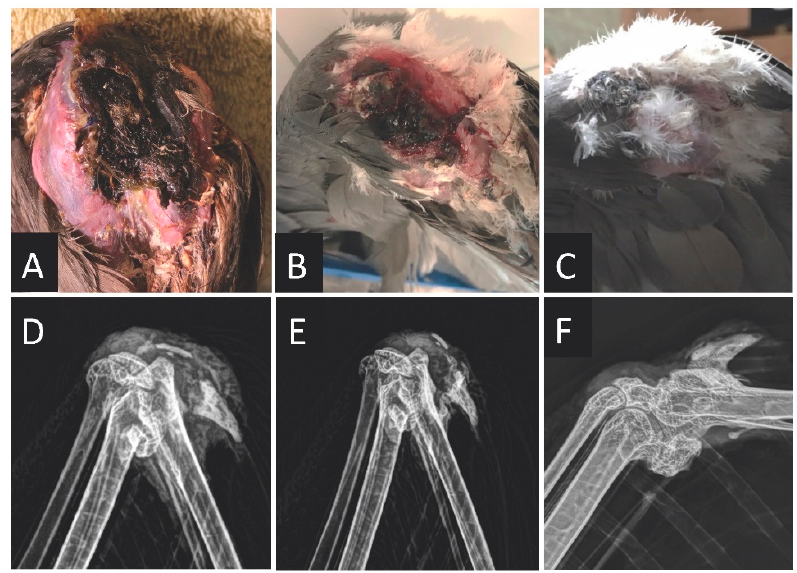
Figure 3. The left carpus of Case 3, an 11-year-old male wattled crane ( Bugeranus carunculatus ), with septic arthritis and suspected alular osteomyelitis at the time of presentation and after treatment with intravenous antibiotic regional limb perfusion. Palmodorsal (PD) photographs of the wound ( A ) 4 days after presentation, ( B ) 6 weeks later, and ( C ) 10 weeks after presentation. PD radiographs ( D ) at the time of presentation, ( E ) 6 weeks later, and ( F ) 16 months after presentation.